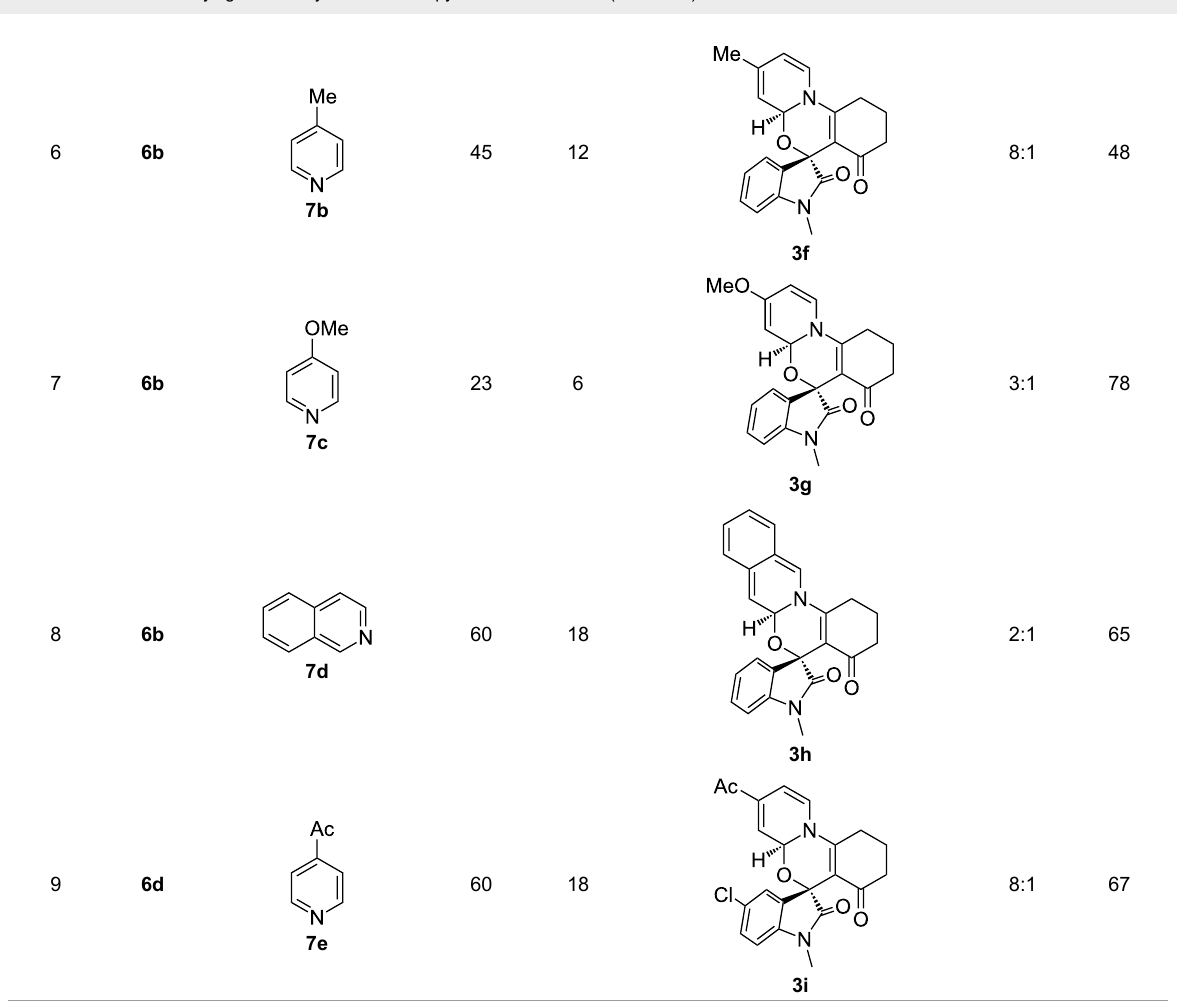
Table 2: Reactions of vinylogous sulfonyl esters 6 with pyridine derivatives 7 .